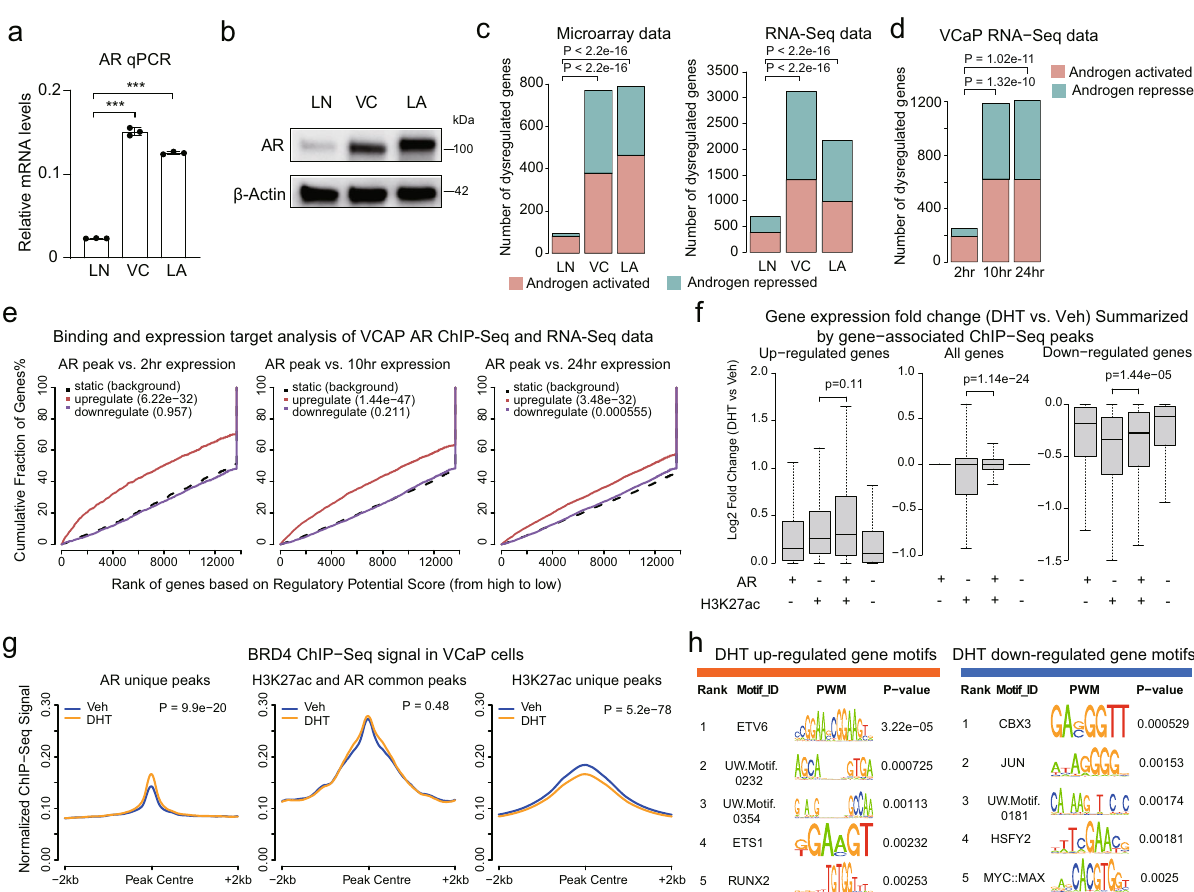
Fig. 1 Global transcriptome assessment identi fi es a disassociation between AR and androgen-elicited transcriptional repression. a RT-qPCR for AR mRNA in LNCaP (LN), VCaP (VC), and AR-overexpressing LNCaP (LNCaP-AR, or LA) cells. Data are mean values ± SD for three biologically independent samples. P values are two-sided Student ’ s t test. ***, P < 0.001. b Western blot of AR in LNCaP, VCaP, and AR-overexpressing LNCaP cells, representative of three replicates. c Statistics of androgen-regulated genes. For microarrays, LNCaP is from Xu et al. 21 LNCaP-AR is from GSE62474. VCaP is from GSE62473. Cutoff for androgen-activated genes is fold change > 1.5 and adjusted P < 0.05. Cutoff for androgen repressed genes is fold change < 2/3 and adjusted P < 0.05. RNA-seq data for LNCaP is from Liang et al. 59 . LNCaP-AR and VCaP RNA-seq data were generated in this report. Cutoff for DHT- stimulated genes, fold change > 2 and adjusted P < 0.05; cutoff for DHT-repressed genes, fold change < 1/2 and adjusted P < 0.05. Chi-squared test determined whether the numbers of regulated genes are different. d Statistics of DHT-regulated genes at different time points in VCaP. Cutoff for androgen activated genes, fold change > 2 and adjusted P < 0.05; cutoff for DHT-repressed genes, fold change < 1/2 and adjusted P < 0.05. Chi-squared test determined if the ratio of regulated genes is different. e Binding and expression target analysis (BETA) for association between AR binding in VCaP cells assessed by ChIP-seq at 12 h after DHT-stimulation (GSE55062) and DHT-driven gene expression at different time points in VCaP cells. Red line indicates DHT-upregulated genes, purple line indicates DHT-downregulated genes. f Boxplots show expression fold changes, which were classi fi ed into AR only, H3K27ac only, H3K27ac/AR common, or None groups based on H3K27ac or/and AR occupancy at ±10 Kb regions of gene TSSs. Box limits, 1st and 3rd quartiles; whiskers, 1.5× inter-quartile range; center line, median. From the left to right, n = 1090, 7989, 591, 2892, 5742, 25829, 1876, 19010, 1527,